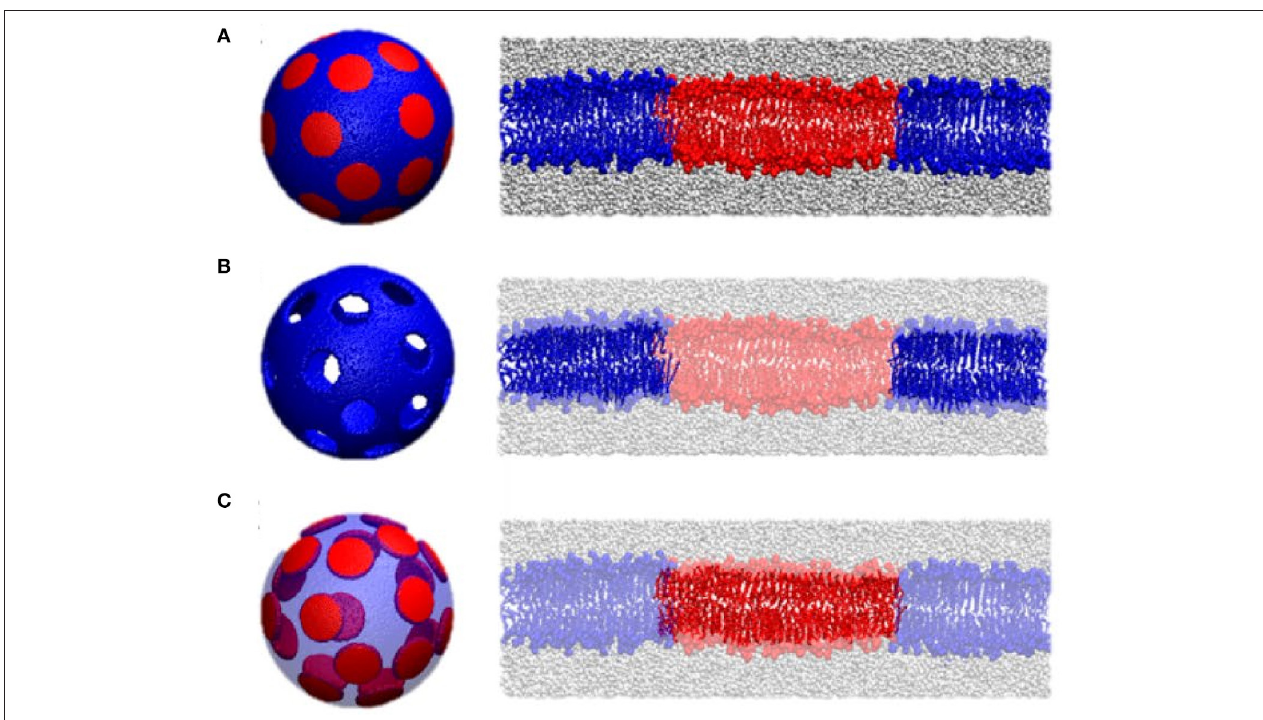
FIGURE 9 | Contrast matching used to study the mechanical properties of lipid domains in 60 nm diameter ULV model membranes. Three contrast matching schemes were used to change the neutrons sensitivity of lipid domains in model membranes. They were: (A) no contrast matching, where the entire ULV is visible to neutrons; (B) domains contrast matched to the solvent in order to highlight the surrounding membrane; and (C) the membrane is contrast matched to the solvent highlighting the nanodomains; Transparent colors indicate contrast matching to the solvent using these three different contrast matching schemes. Figure adapted from Nickels et al.